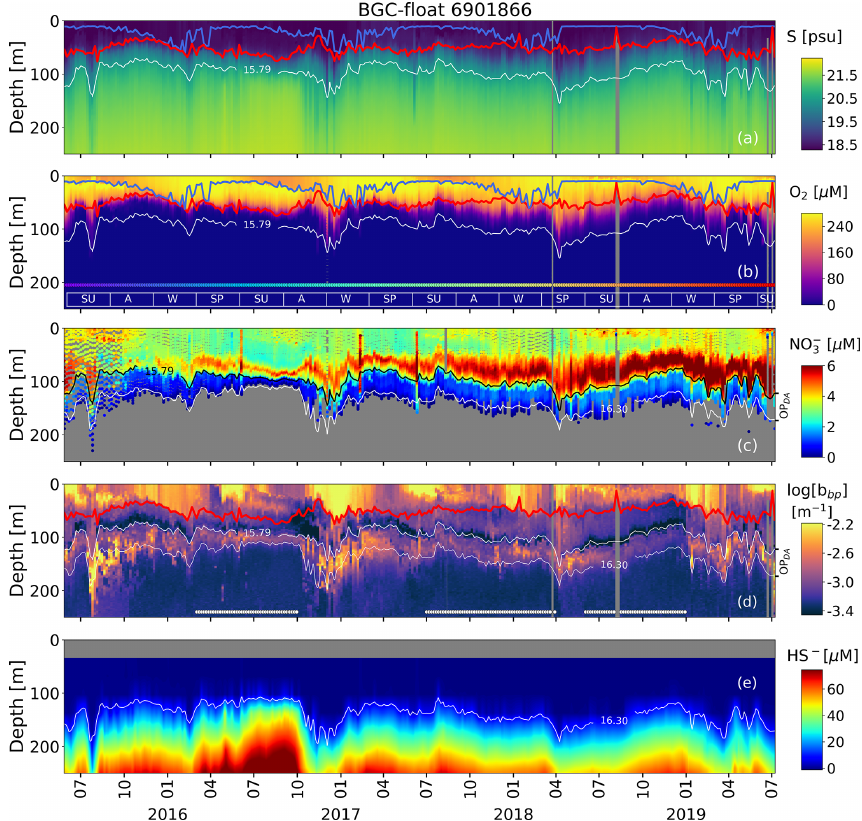
Figure 2. Time series of (a) salinity ( S ), (b) O 2 , (c) NO − , (d) log( b bp ) , and (e) HS − . The blue lines in (a) and (b) indicate the mixed-layer 3 depth. The red lines in (a) , (b) , and (d) show the base of the productive region. Isopycnals 15.79 and 16.30kgm − 3 describe the top and bottom of the oxygen-poor zone (OP DA ), respectively. SU, A, W, and SP stand for summer, fall, winter, and spring, respectively. The colored horizontal line in (b) indicates the sampling site for a given date (Fig. 1). The horizontal white lines in (d) are the profiles used to (1) delimit the OP DA and (2) compute correlations between b bp , NO − , and T within the OP DA 3